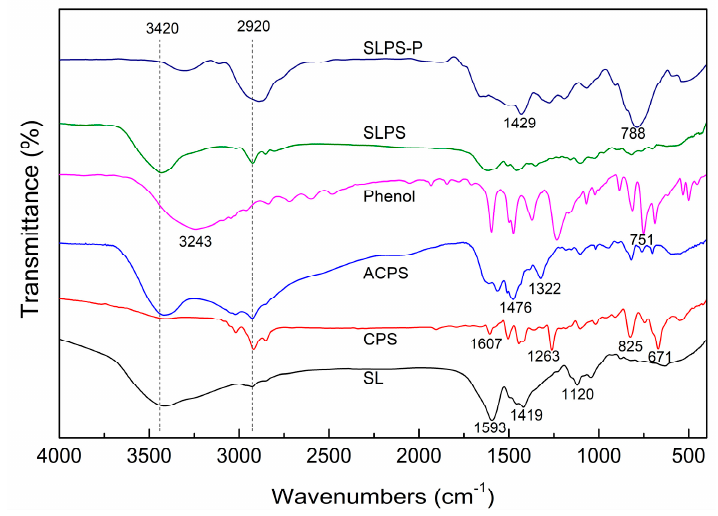
Figure 5. FT-IR spectra of the sodium lignosulfonate (SL), CPS, ACPS, phenol, SLPS, and SLPS-P Figure5. FT-IRspectraofthesodiumlignosulfonate(SL),CPS,ACPS,phenol, samples.